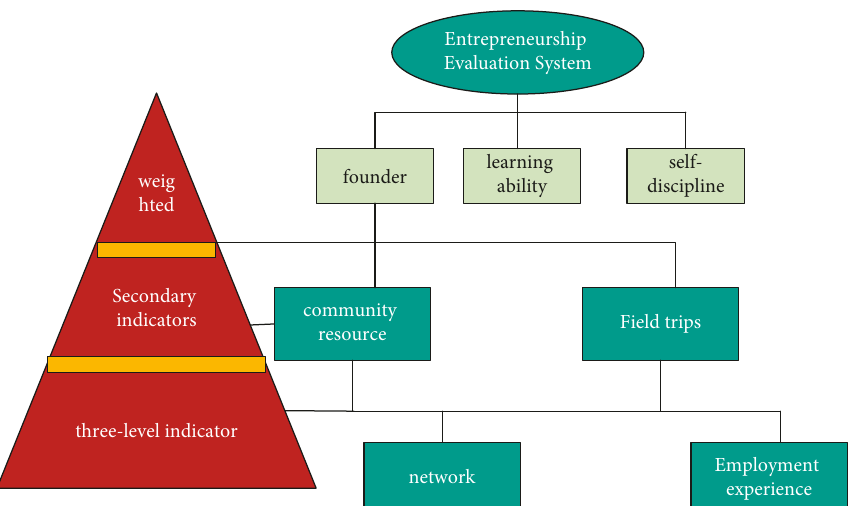
Figure 1: IEA evaluation